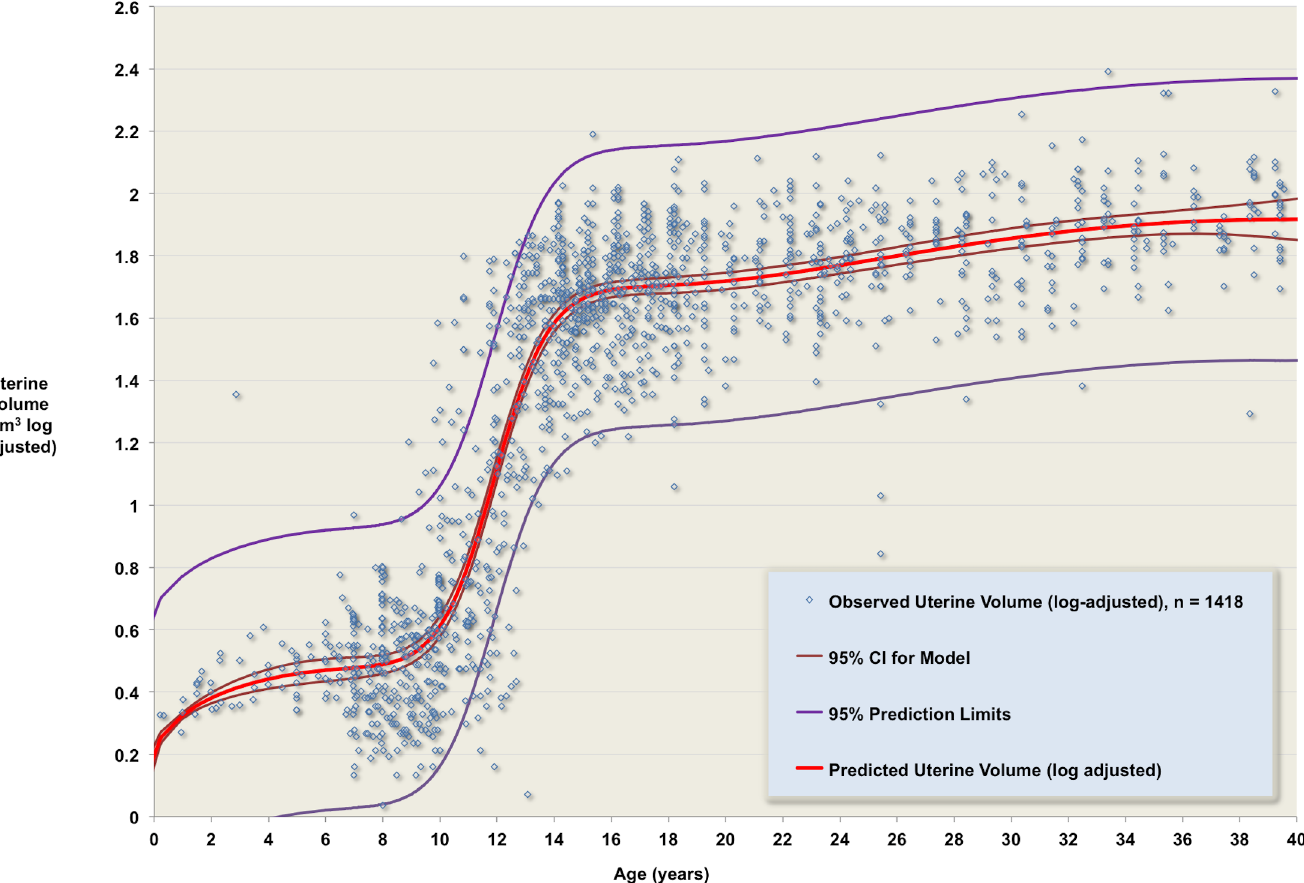
Fig 2. Log-adjusted data and normative model. The observed volumes (blue points) are shown with the predicted volume (red line), the 95% confidence interval for the predicted volume (brown lines), and the 95% prediction limits for the model (purple